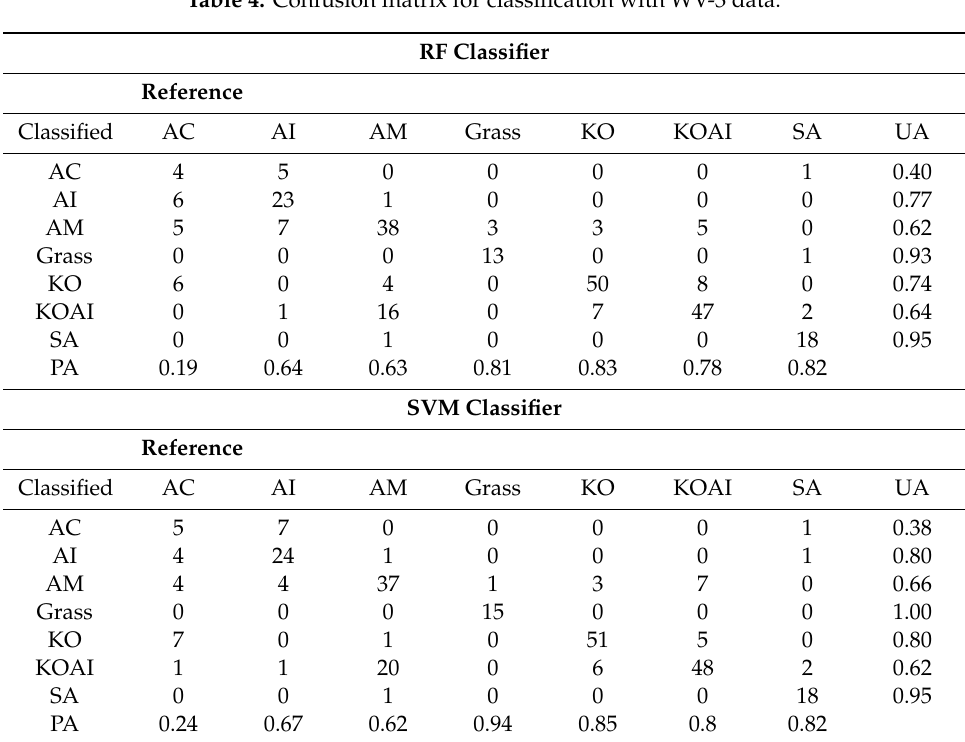
Table 4. Confusion matrix for classification with WV-3 data.